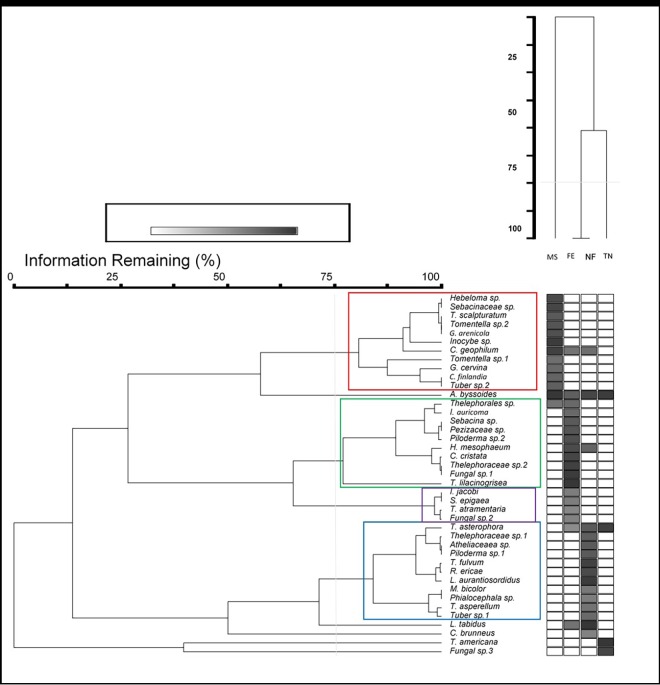
Two-way cluster analysis (α = 0.05) showing groups of species thriving in same habitats (small coloured rectangles) (darker grey squares mean higher abundance; Big red rectangle = no difference between site species composition).